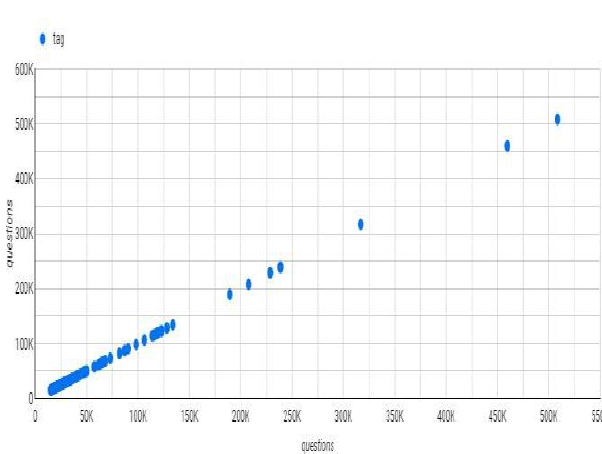
Figure 5. Scatter chart for Top 100 Tags and frequencies between (2018-2019).